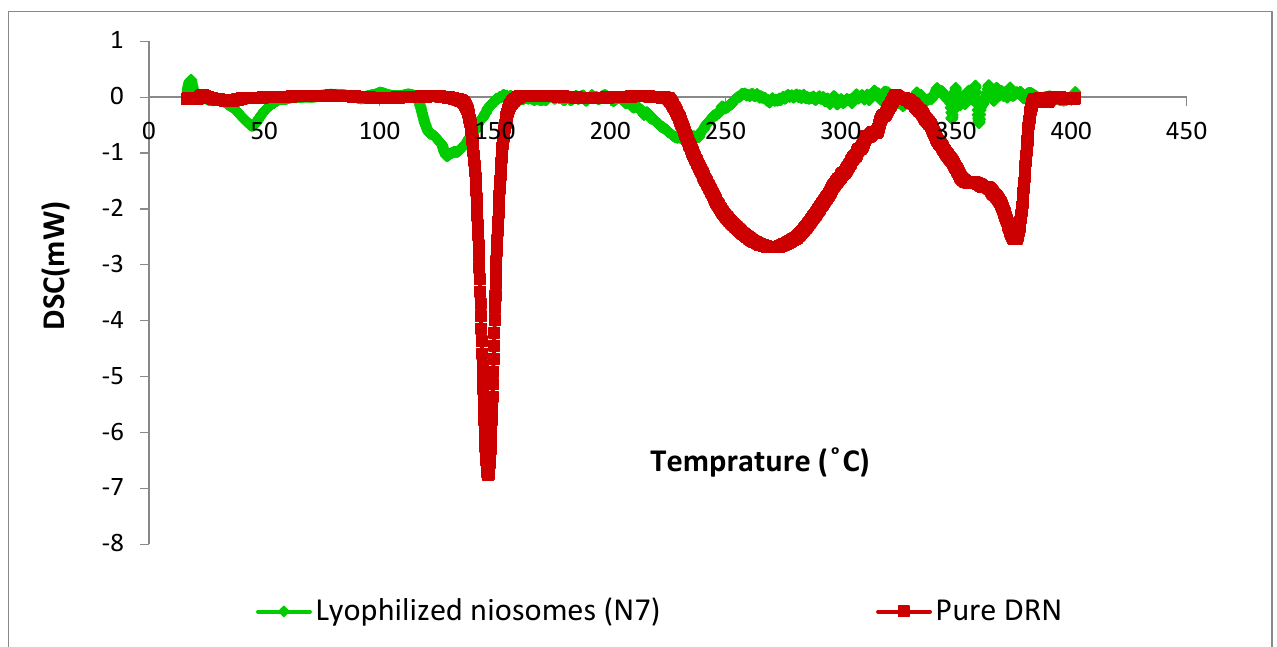
Figure 3. Thermograms of pure DRN and lyophilized optimal DRN loaded niosomes (N7).